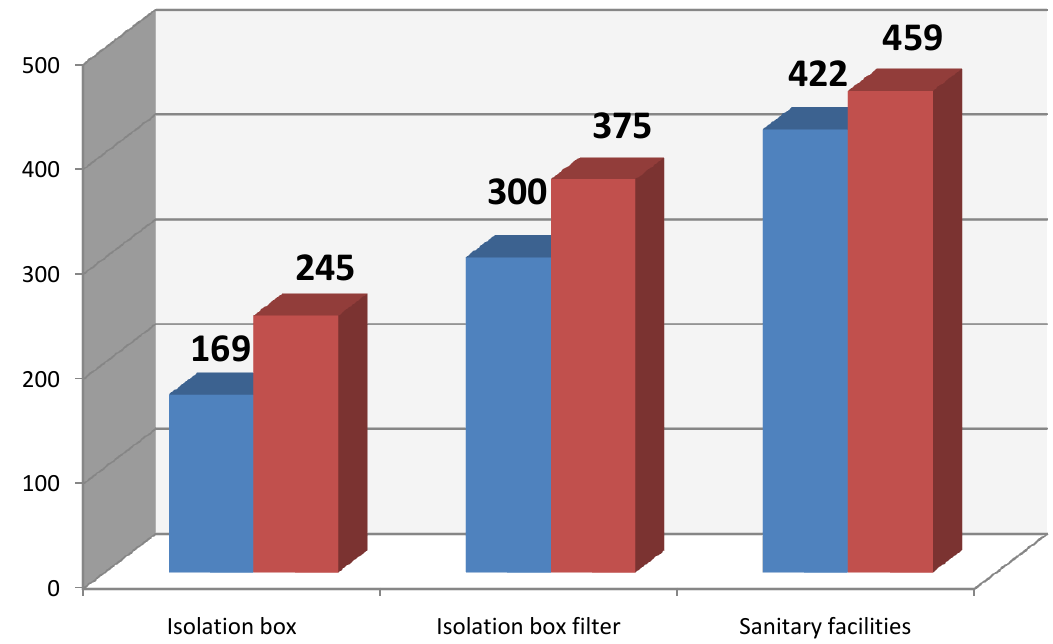
Figure 2. Average CFU/m 3 (blue without patient, red with